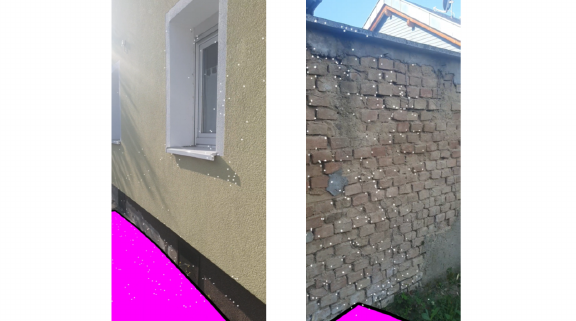
Figure 2. ARCore feature